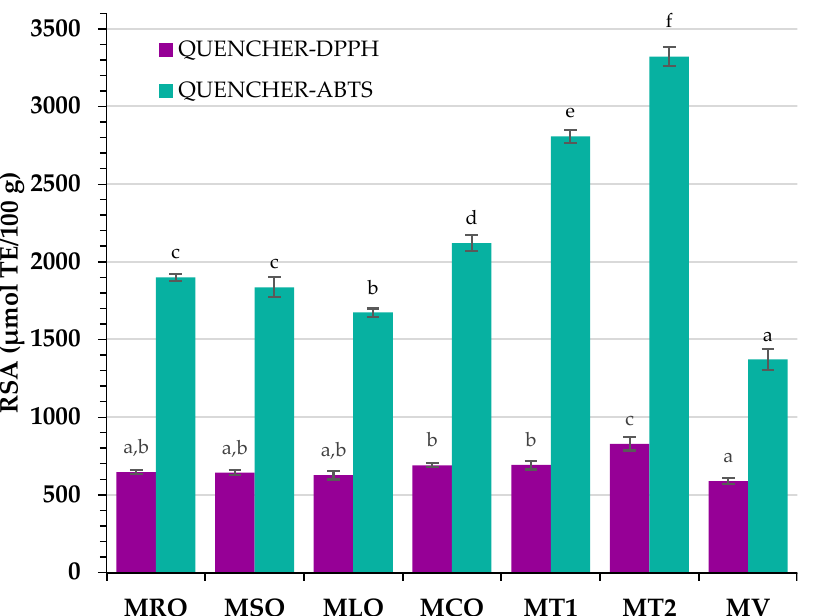
Figure 2. Radical scavenging activity of aquafaba-based mayonnaises with blends of refined rapeseed oil and cold-pressed rapeseed oil (MRO), cold-pressed sunflower oil (MSO), cold-pressed linseed oil (MLO), and cold-pressed camelina oil (MCO); MT1—commercial egg yolk mayonnaise from producer 1; MT2—commercial egg yolk mayonnaise from producer 2; MV—commercial vegan